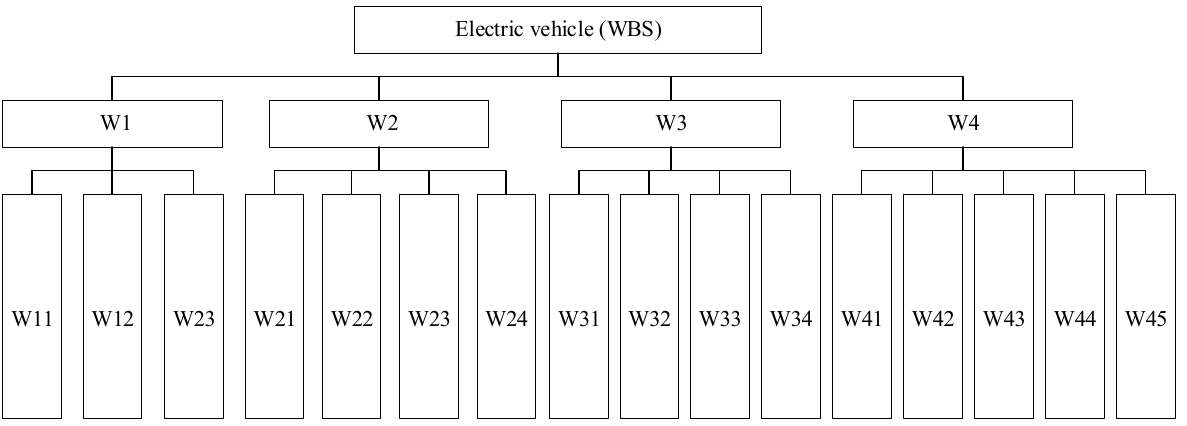
Figure 7. Electric vehicle WBS decomposition structure tree. Table 2. Name of electric vehicle system corresponding to each number in WBS